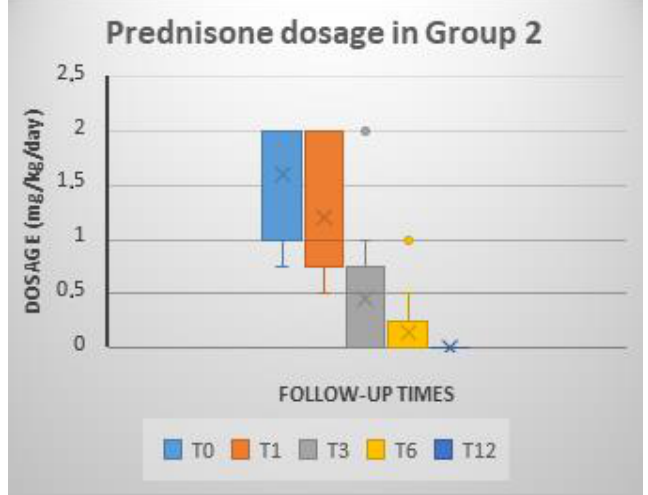
Figure 6. Values of the prednisone dosage (mg/kg/day) in the P-MSC group at each of the reviews.